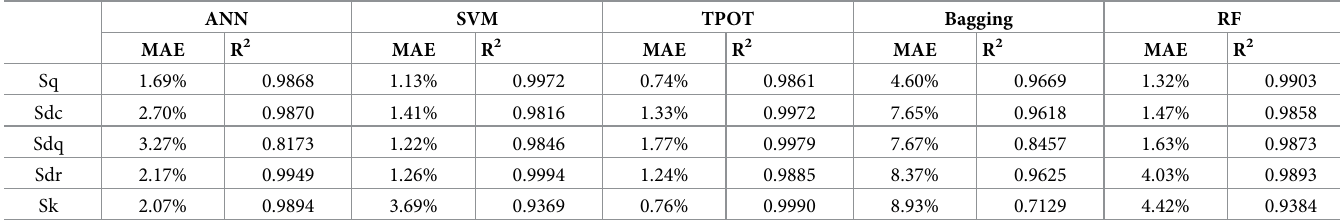
Table 2. Modeling effect of different automl